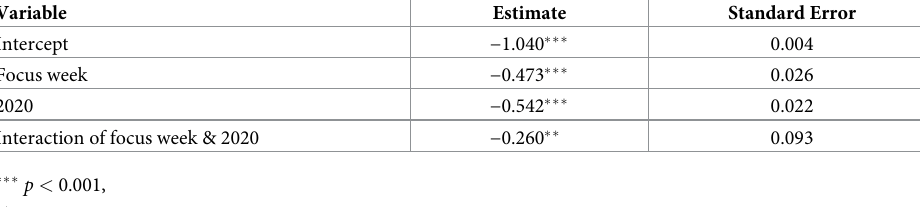
Table 1. Logistic regression model for readmission. As a proxy for reoffense, we use a dichotomous outcome variable indicating whether or not an individual discharged during a given calendar year was readmitted in the same calendar year. The model includes four parameters: an intercept; an indicator fixed effect for release during the week of March 23—29; an indicator fixed effect for release during 2020; and an interaction effect for release specifically during March